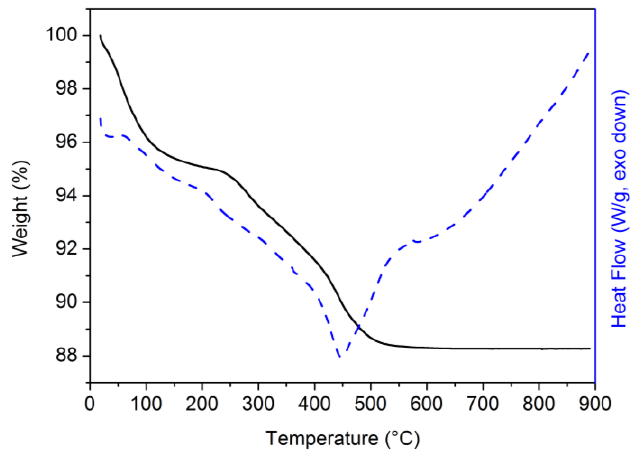
Figure 3. TGA (continuous line) and DSC (dashed line) curves of L66 mortar cured at room temperature for 7 days in >95% relative humidity